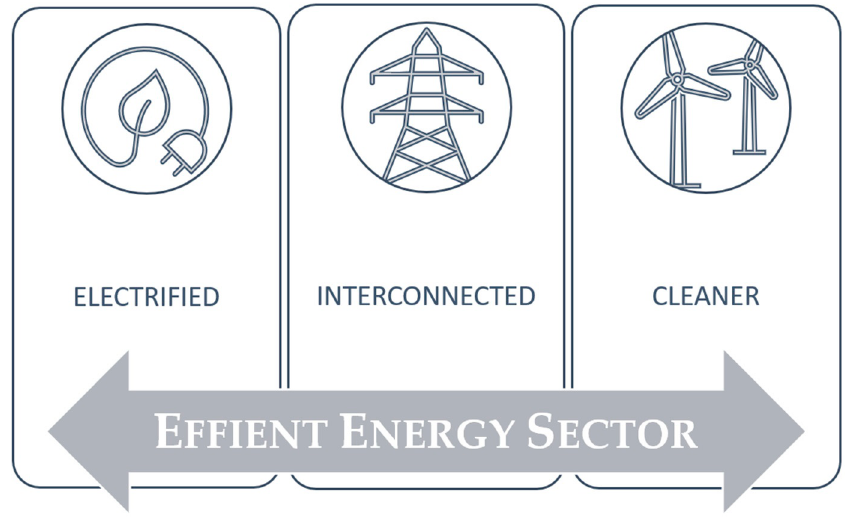
Figure 5. Characteristics of the energy system to achieve the decarbonization of the energy